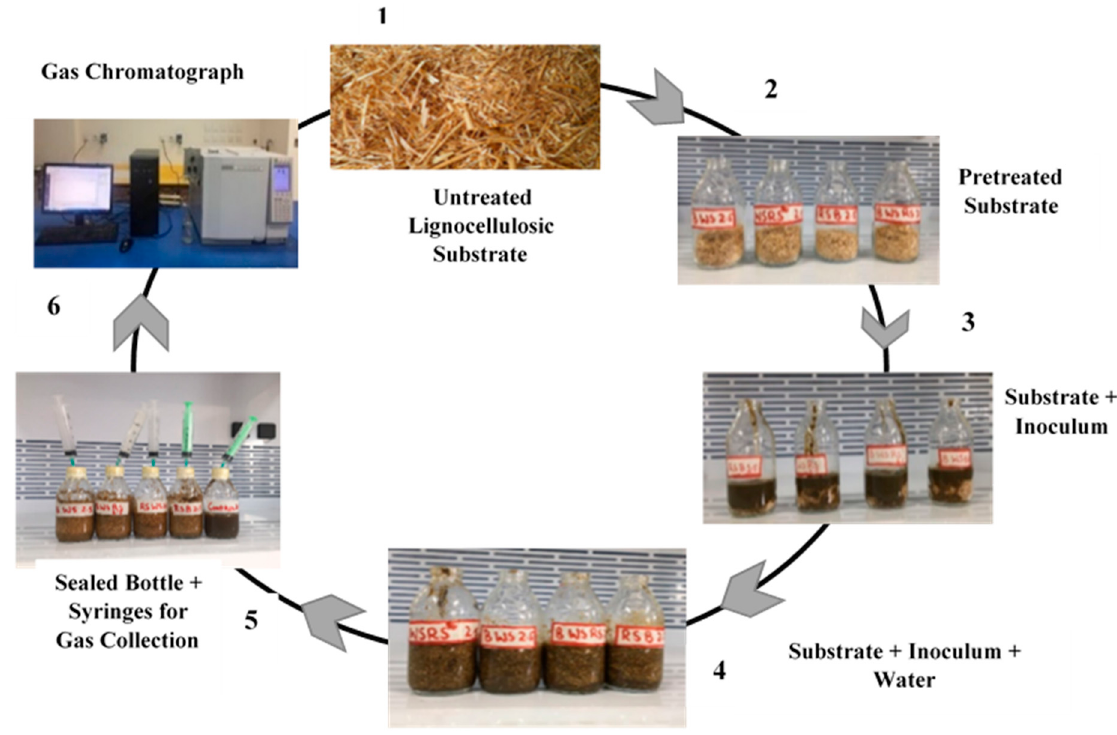
Figure 1. Lab-Scale Biochemical Methane Potential Setup.